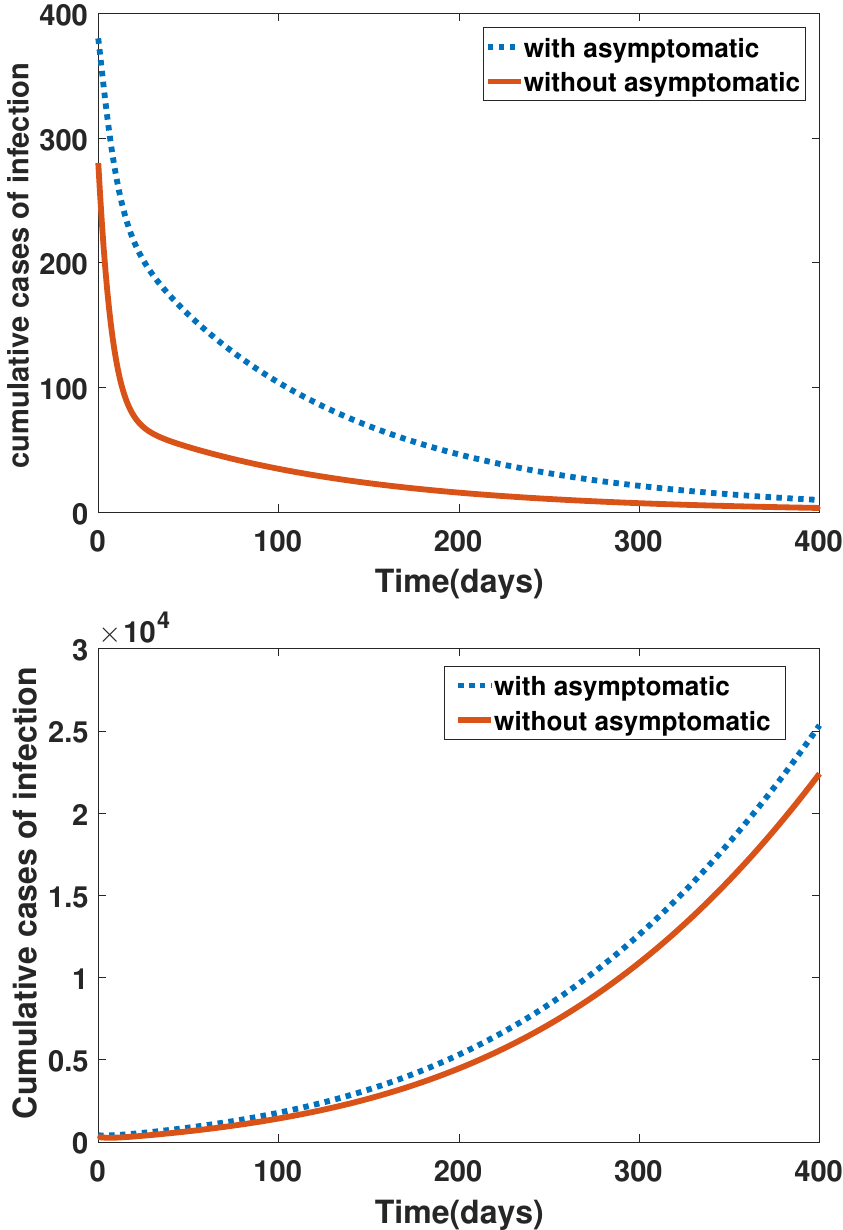
Figure 4. The plot of the cumulative cases of infection verses time in days with treatment (dotted line) and without treatment (solid line) when R 0 = 0.7468 < 1 ( Up ). The plot of the cumulative cases of infection verses time in days with treatment (dotted line) and without treatment (solid line) when R = 1.4936 > 1 ( Down 0